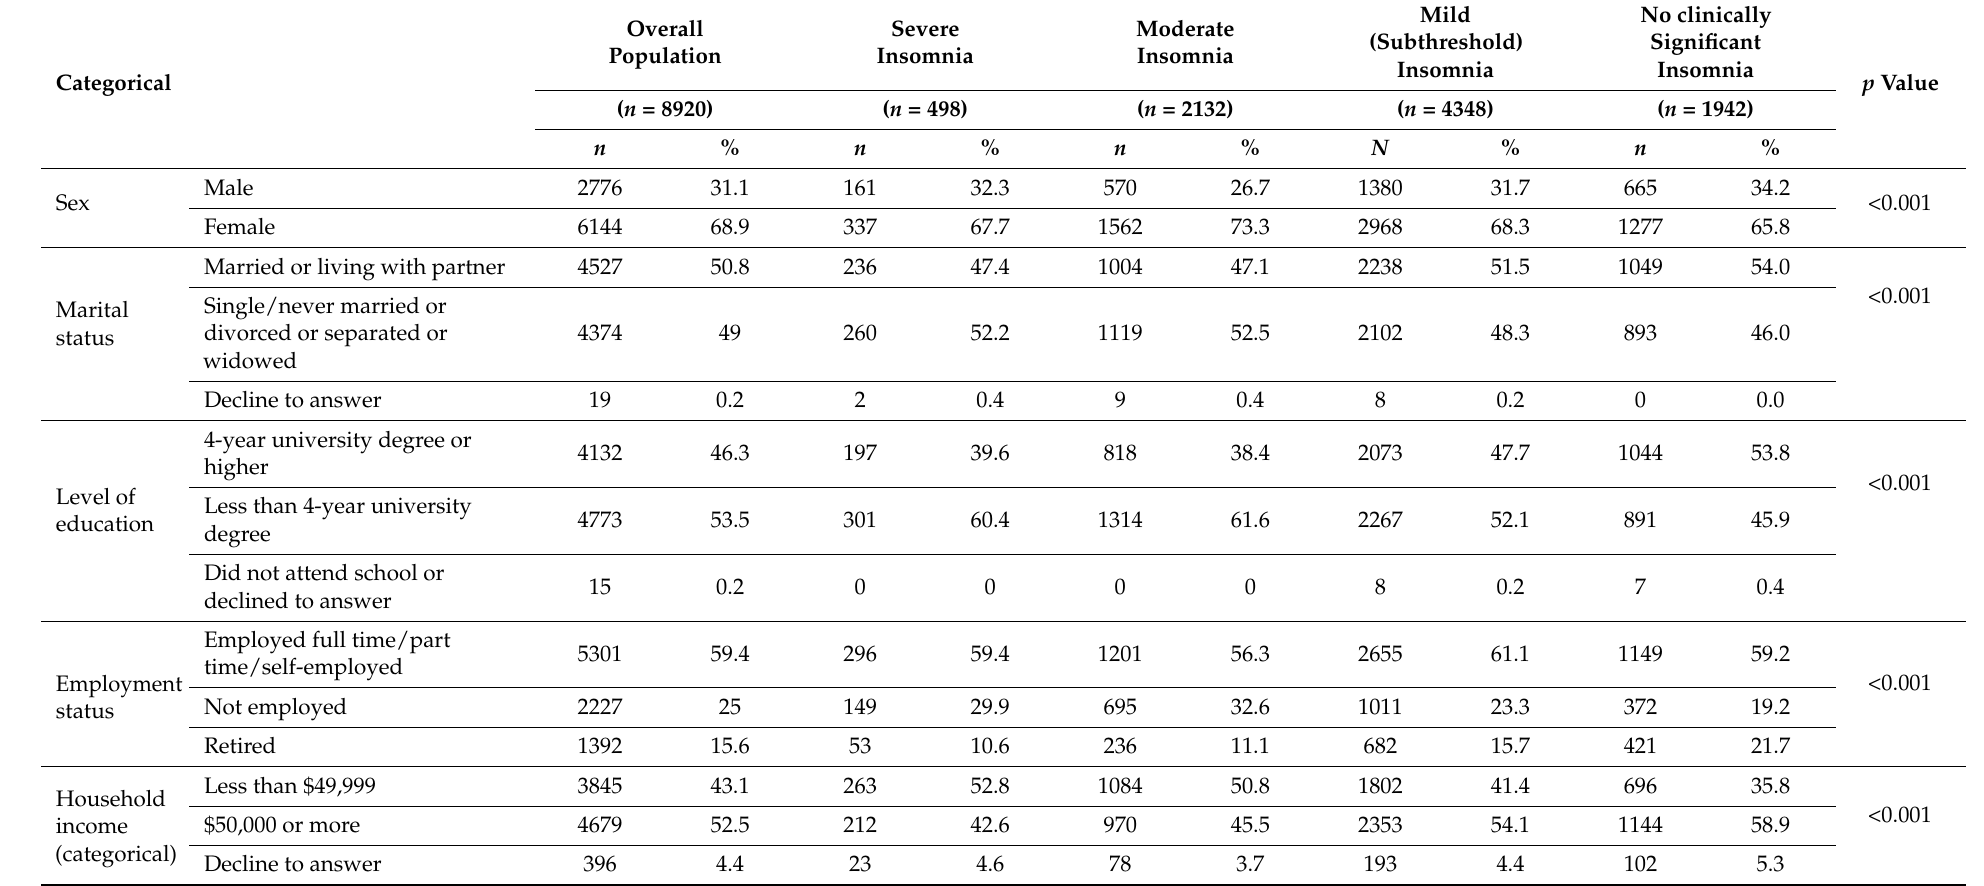
Table 1. Characteristics of study population, overall and by ISI severity